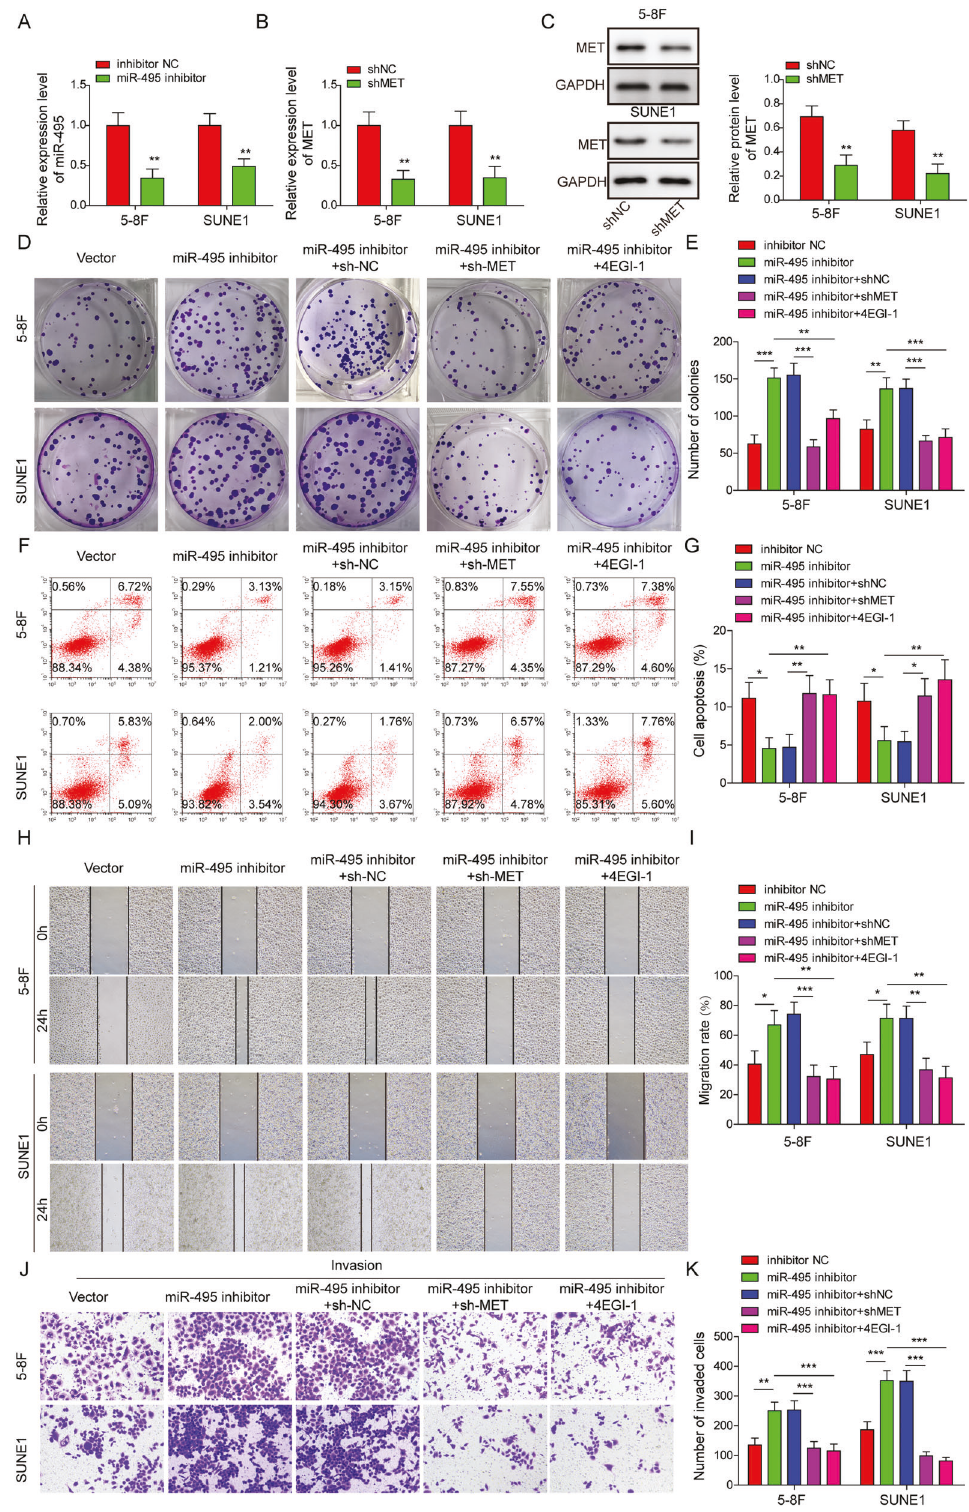
Fig. 6 miR-495 knockdown promoted NPC malignant phenotypes and inhibited cell apoptosis by activating the MET-eIF4G1 translational regulation pathway. NPC cells were transfected with inhibitor NC, miR-495 inhibitor, miR-495 inhibitor + sh-NC, or miR-495 inhibitor + sh-MET respectively or treated with 4EGI-1 after miR-495 inhibitor transfection. A , B The relative expression of miR-495 and MET. Data from three independent experiments was normalized to GAPDH. C Western blotting analysis of MET. D , E Colony formation analysis of NPC cells. F , G Cell apoptosis analysis by fl ow cytometry. Scratch wound healing H , I and transwell invasion J , K analysis for 5 – 8 F and SUNE1 cells. * P < 0.05, ** P < 0.01, and *** P < 0.001.